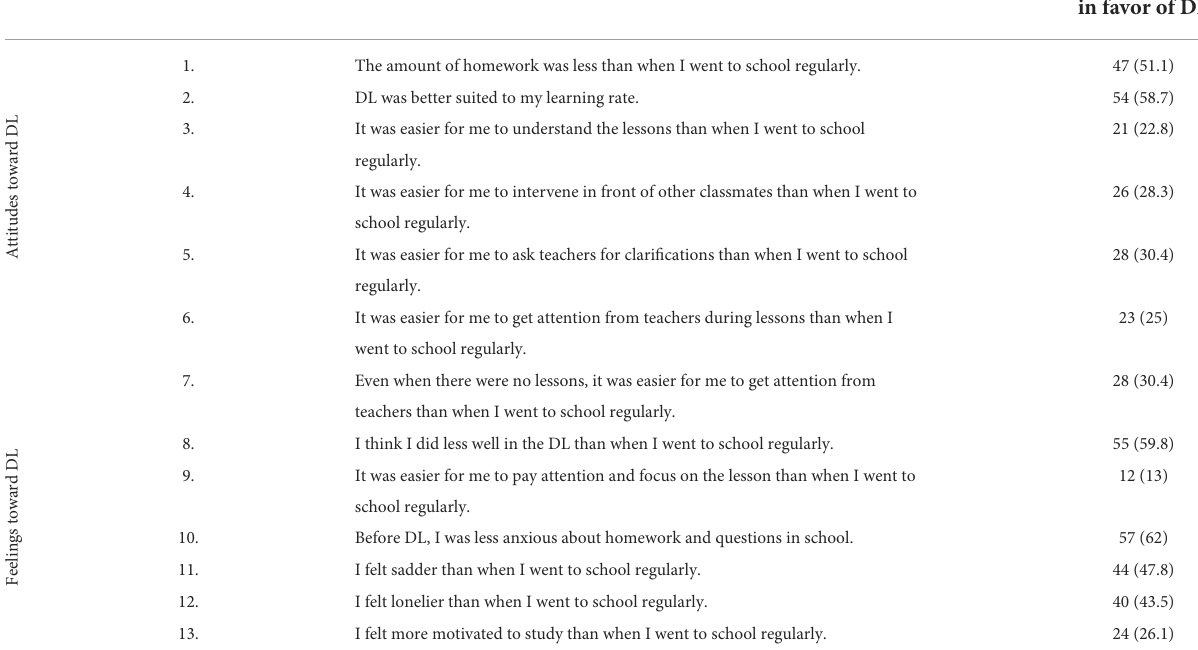
TABLE 4 The percentages of students with SLD in favor of DL compared to in-person learning in terms of attitudes (items 2–7) and feelings (items